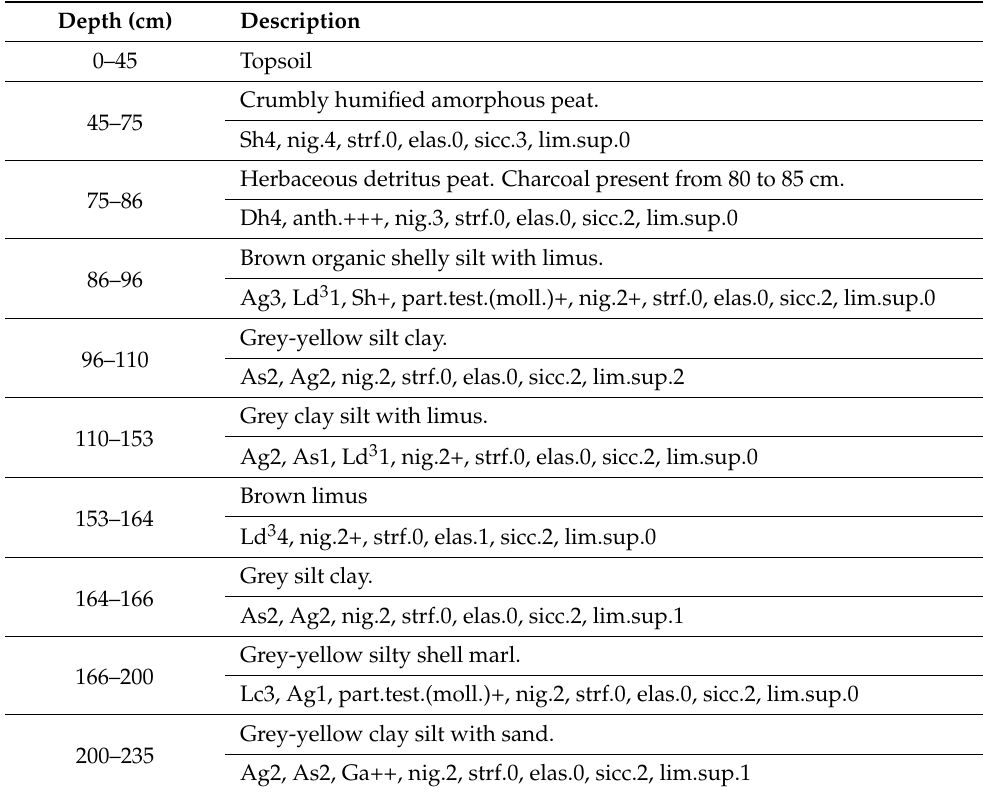
Table 3. Lithostratigraphy at Nosterfield, the Flasks 69. Altitude 39.26 m